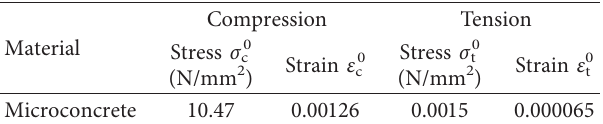
Figure 3: Stress-strain relation obtained from the Chinese concrete code. Table 3: Properties of the microconcrete.